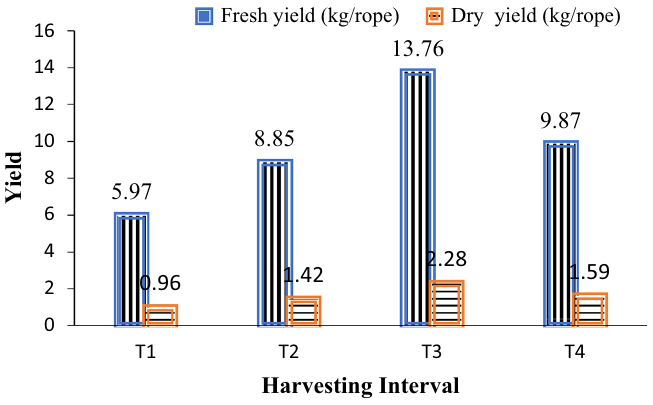
Figure 1. Effect of harvesting interval on the yields of Gracilaria tenuistipitata.